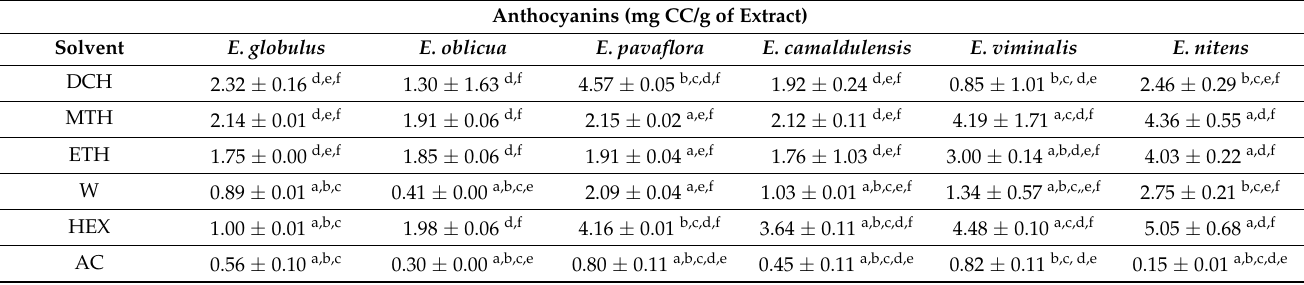
Table 5. Anthocyanins obtained, expressed as mg cyanine chloride /g extract.